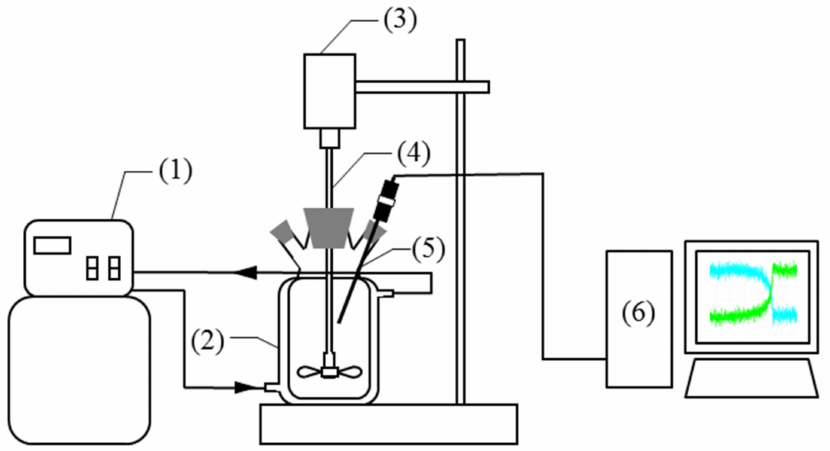
Figure 2. The experimental setup of solution-mediated polymorphic transformation between the two polymorphs of L-carnosine: ( 1 ) thermostat; ( 2 ) crystallizer; ( 3 ) mechanical stirrer; ( 4 ) stirring paddle; ( 5 ) Raman probe; ( 6 )